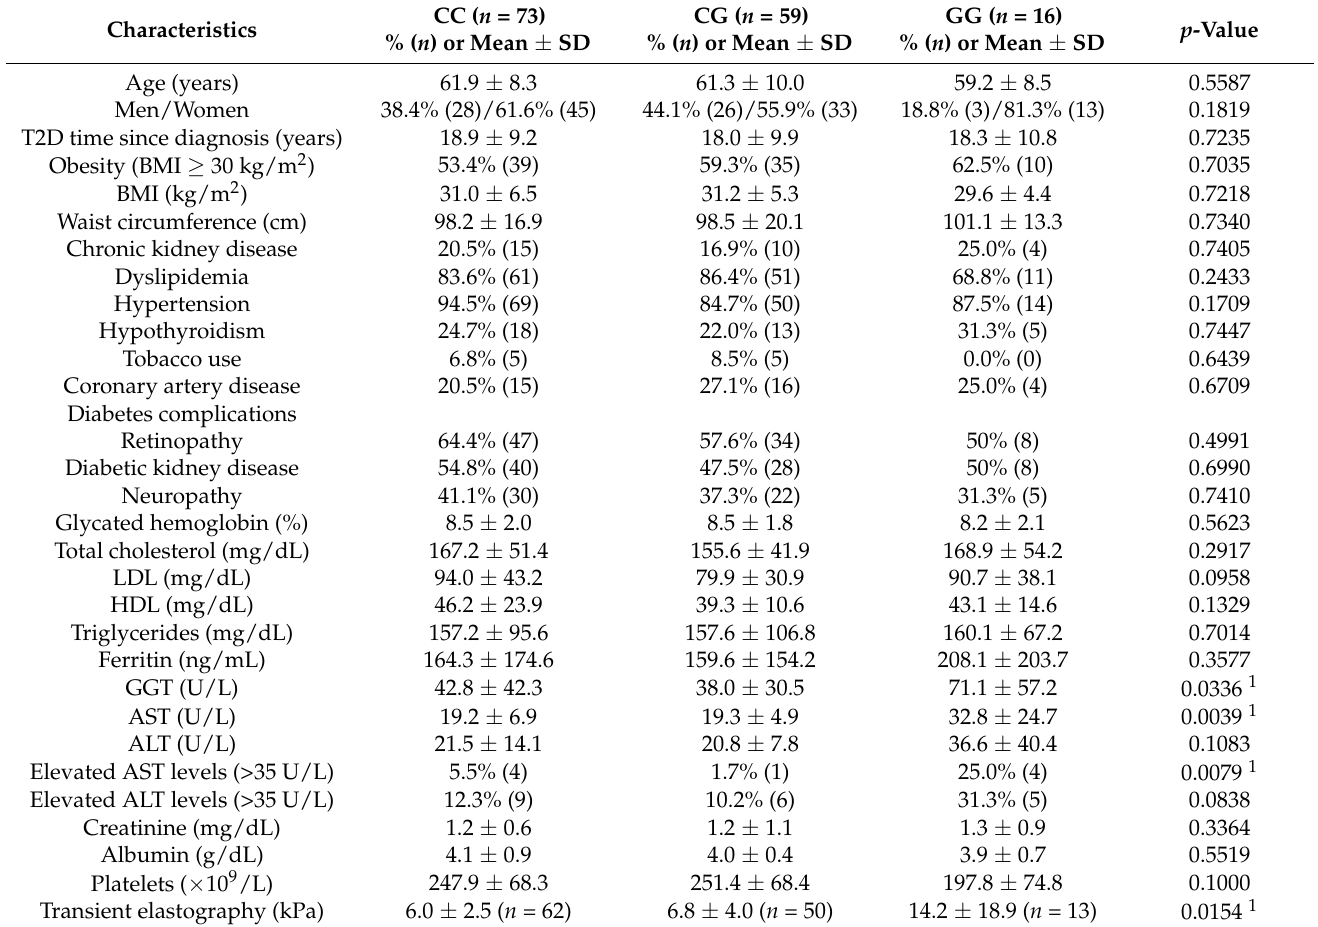
Table 6. Demographic, clinical, and biochemical characteristics of the genotypes of the single nu- cleotide polymorphism in PNPLA3 in patients with T2D ( n =